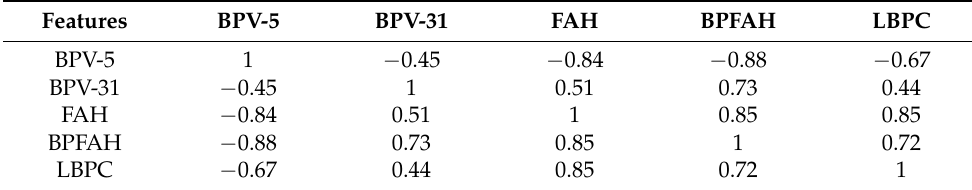
Table 4. Correlation between the 5